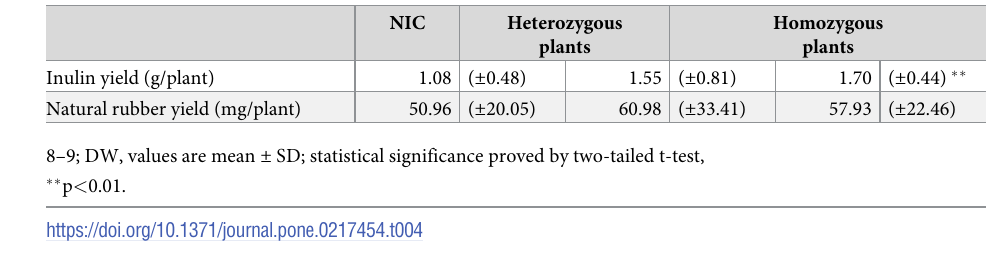
Homozygous plants